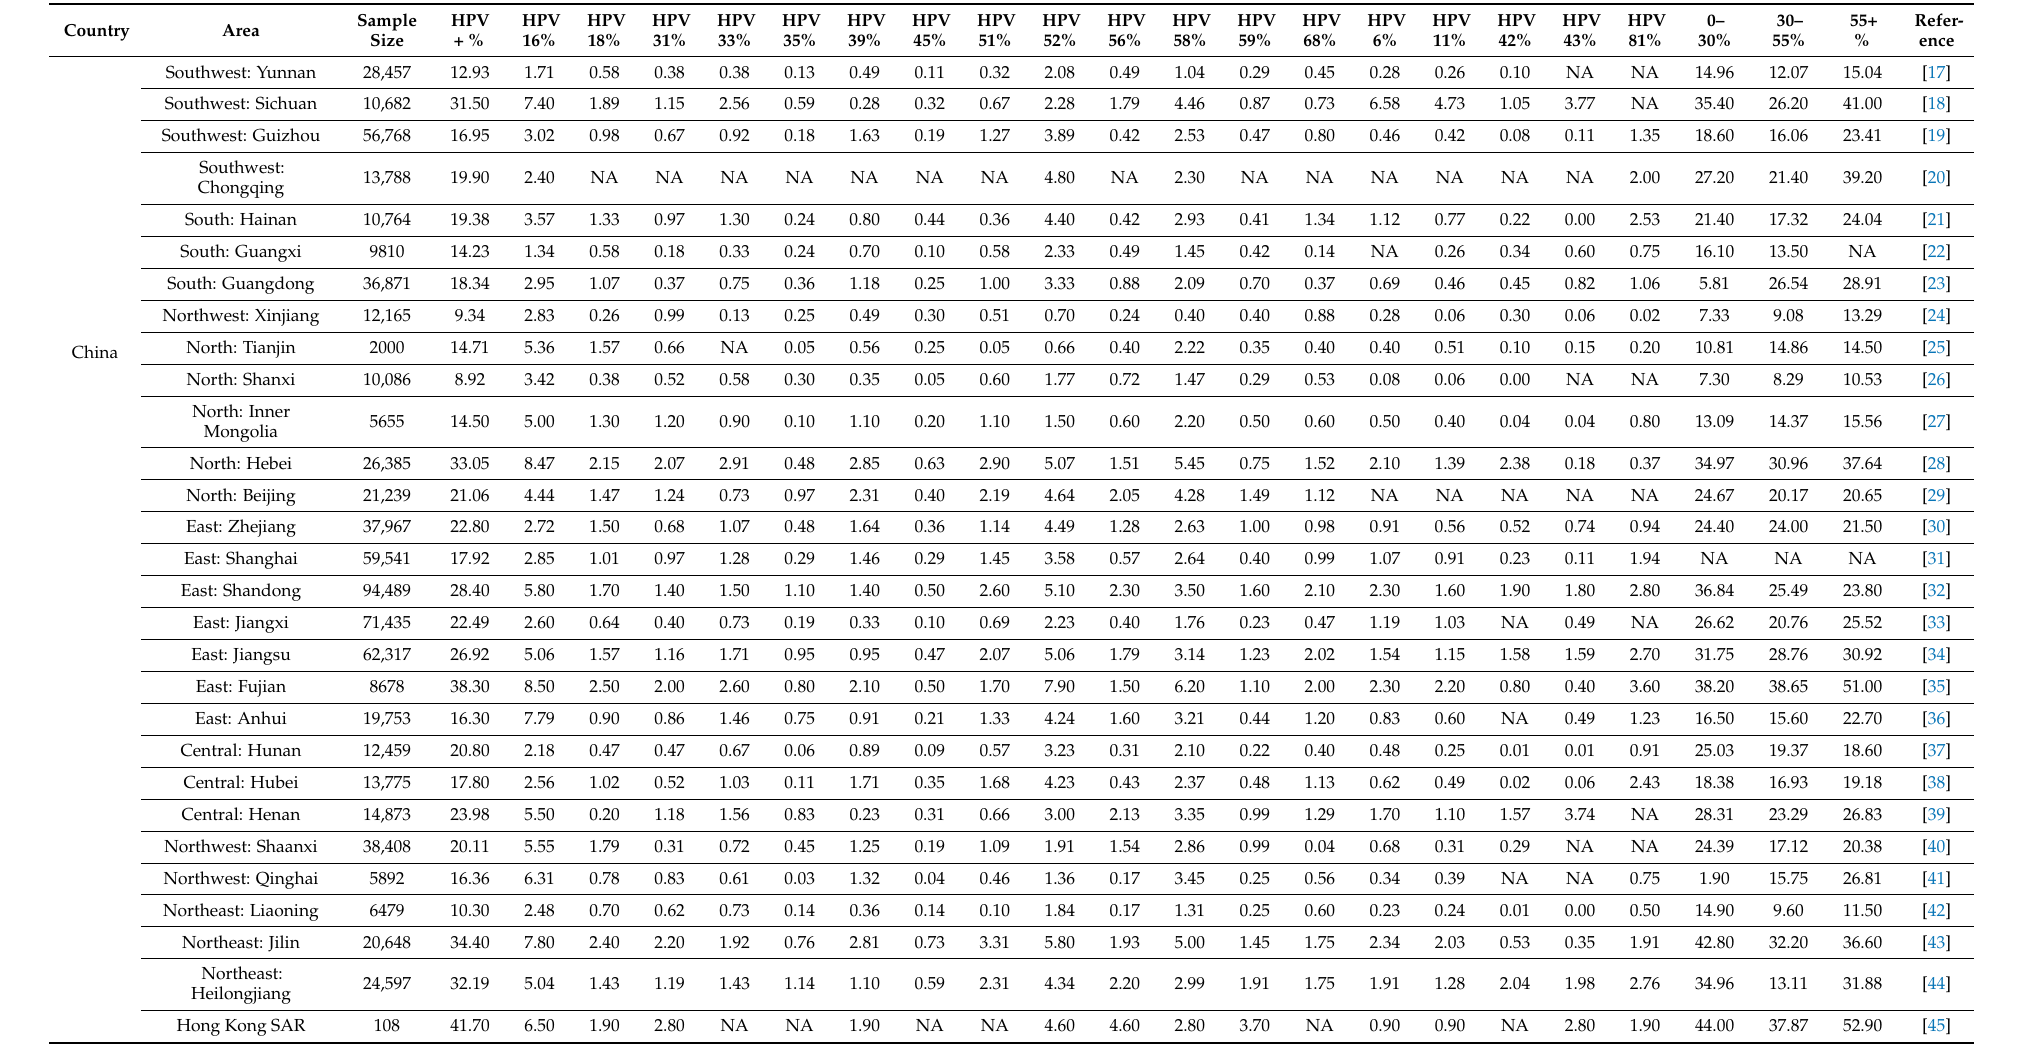
Table 3. The HPV prevalence of genotypes and different age groups of a normal population in East